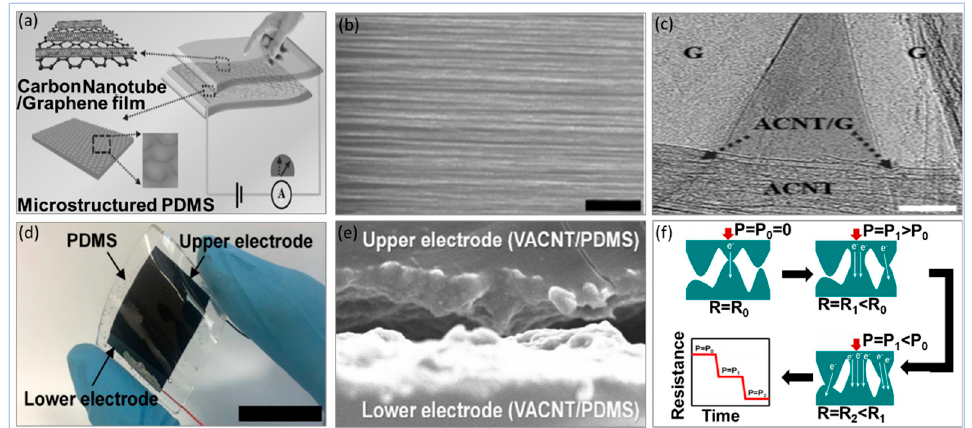
Figure 12. ACNT-Graphene@PDMS. Reproduced with permission [259] Copyright 2017, Wiley. ( a ) Schematic illustration showing the structure of the ACNT-Graphene pressure sensor. ( b ) SEM and optical images of continuous ACNT films drawn from VACNT arrays. ( c ) TEM image of ACNT-Graphene hybrid film. The areas marked by “G” indicate Graphene, and the area labelled by “ACNT” shows the ACNT film, and the regions mentioned by “ACNT/G” demonstrate the incorporation of ACNTs and Graphene. VACNT@PDMS. Reproduced with permission [260] Copyright 2017, American Chemical Society. ( d ) Digital image of the fabricated sensor. ( e ) Cross-sectional SEM image of the sensor. ( f ) Schematic illustration of the basic working principle of the sensor.